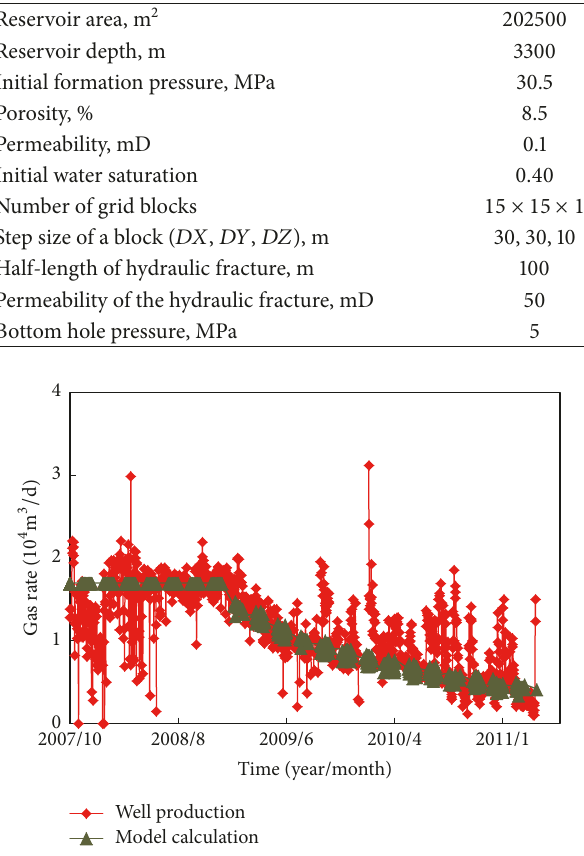
Figure 6: The comparison between well production and results of model